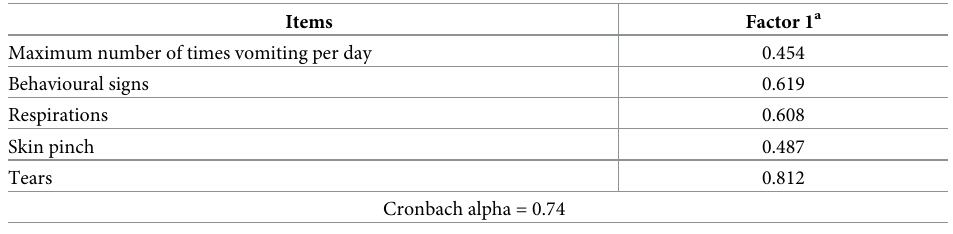
Table 4. Factor extraction with orthogonal rotated factor loadings above 0.40.